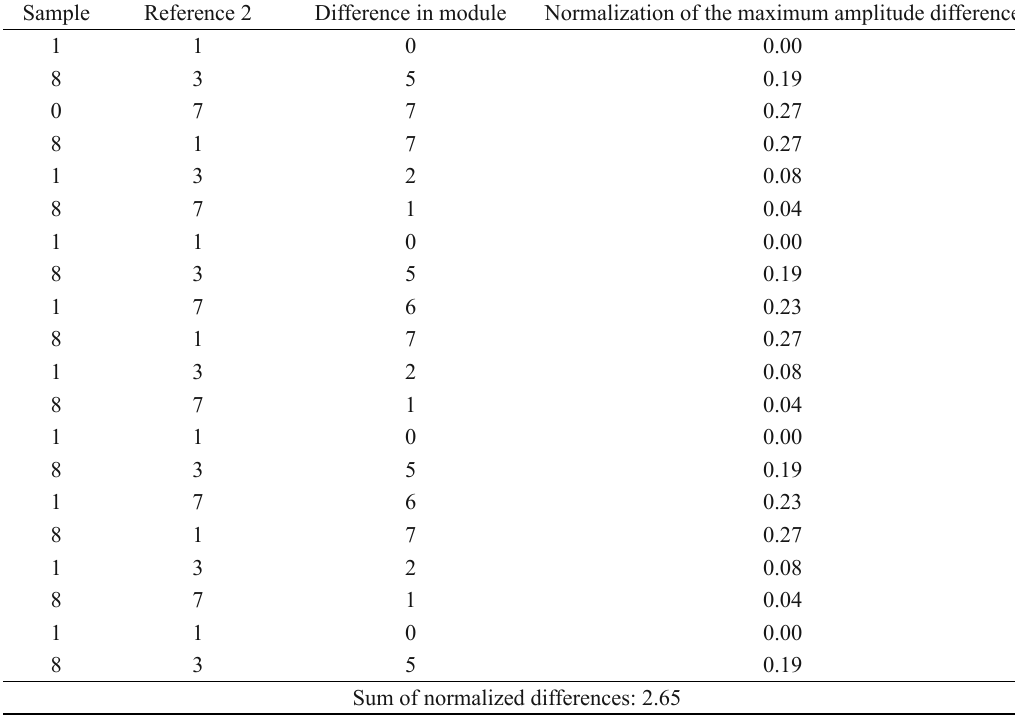
Comparison between the sample and reference2.